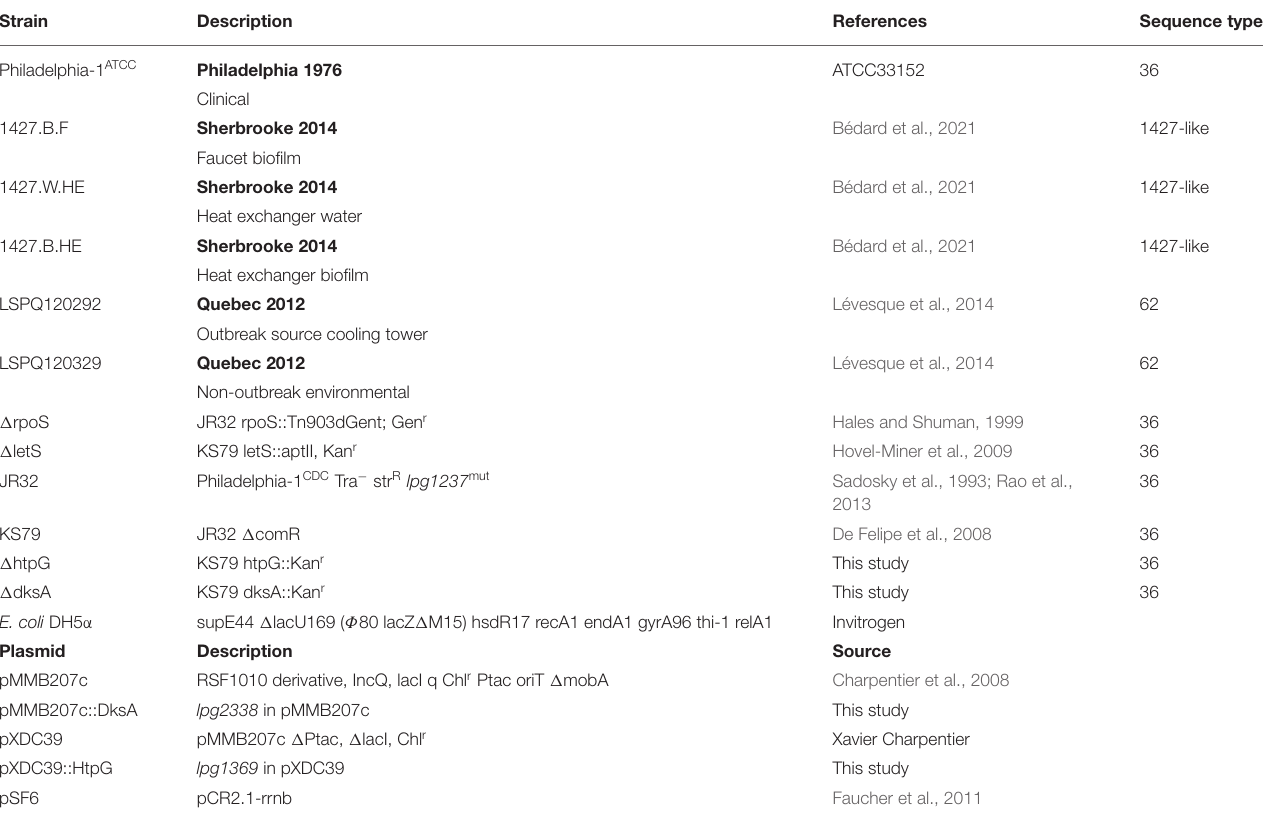
TABLE 1 | Bacterial strains and plasmids used in this study.